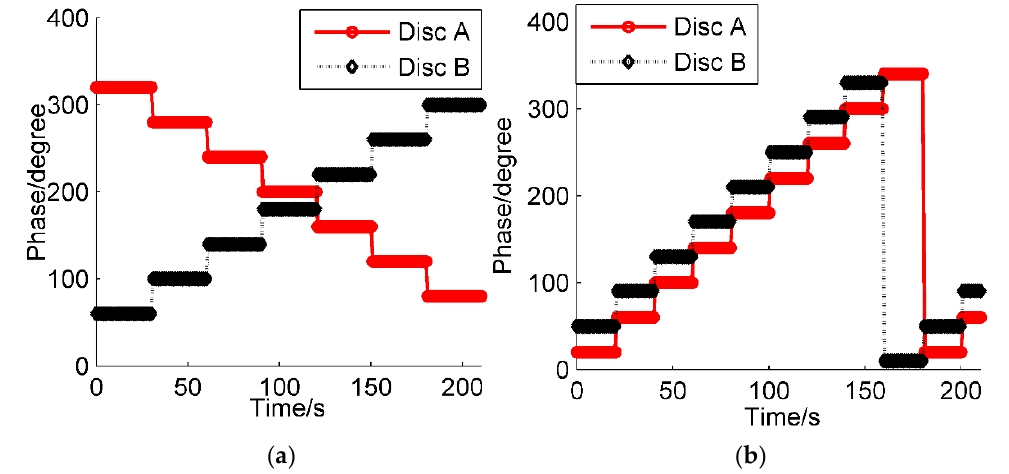
Figure 19. Step rotation experiments of the actuator: ( a ) In the opposite direction; ( b ) In the same direction.